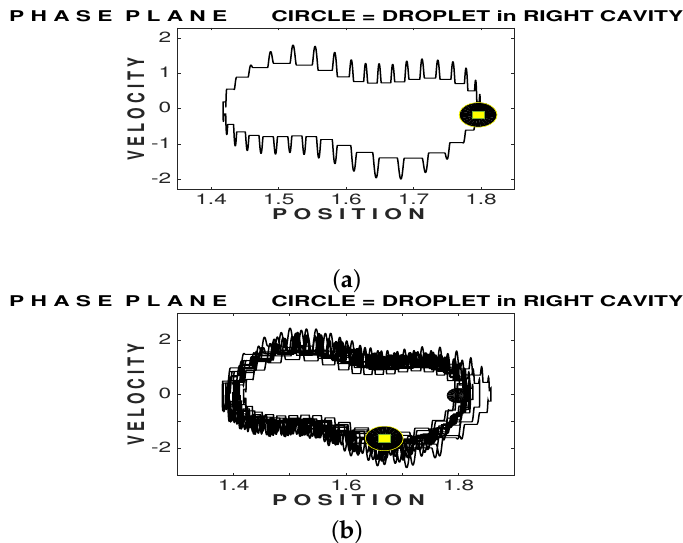
Figure 5. ( a ) On the left, a single droplet is confined to the right-most cavity and oscillates uniformly. The underlying wave sloshing is depicted for the first 100 Faraday periods. The barriers are high with a fluid depth of only 0.02 cm above each barrier. There is very mild wave activity in the mid-cavity. ( b ) On the right graph the droplet dynamics are viewed for two different heights of the right-most barrier. The left barrier is kept unchanged with a fluid depth of 0.02 cm above it. In black, and running beyond time t = 250 T F , is the case for a fluid depth of 0.02 cm above both barriers. In red is the case for a lower right barrier, with a fluid depth of 0.04 cm above it. A secondary forcing from a distance is observed, due to the wave action in the mid-cavity.